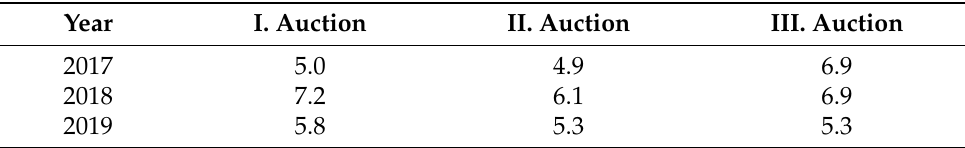
Table 5. The average project size on the German PV auctions, in 2017, 2018 and 2019, source: